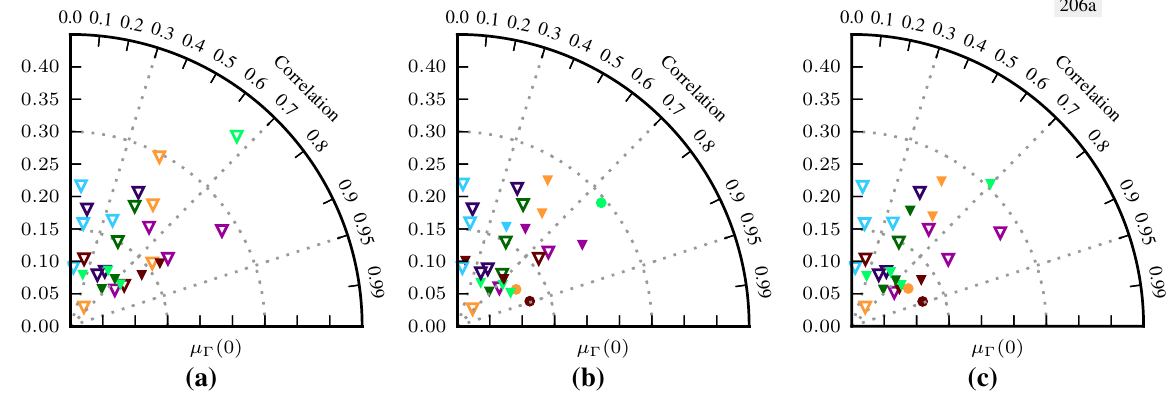
Figure 11. Taylor plots for bicoherence calibration based on HH phase triplets: ζ “ 0 ; cf. Figure 6 for a description of these plots. The value of the estimated a in ( c ) is –0.65. 1 ( a ) Ξ , A “ 0 , Hal; ( b ) Ξ , A “ 0 , Pep; ( c ) Ξ , A “ 1 , HAL. HH HH HH